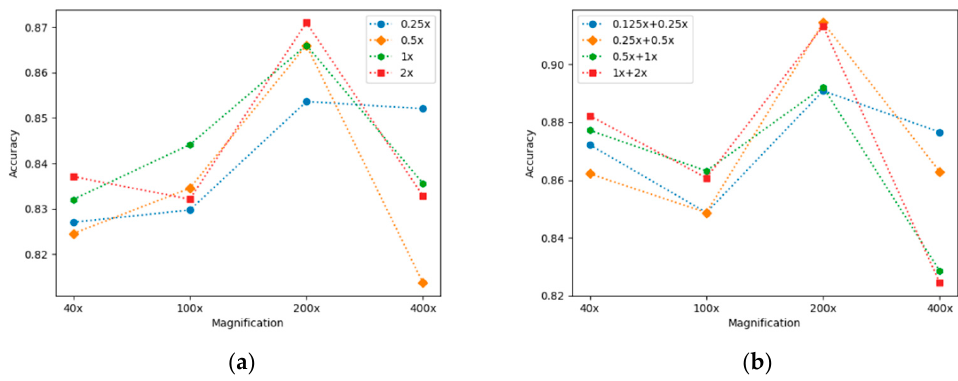
Figure 9. ( a ) Single-scale input-image accuracy; ( b ) Multi-scale input-image accuracy. Comparison of the classification accuracy of multi-scale input-image method with single-scale input-image on four different magnifications database.